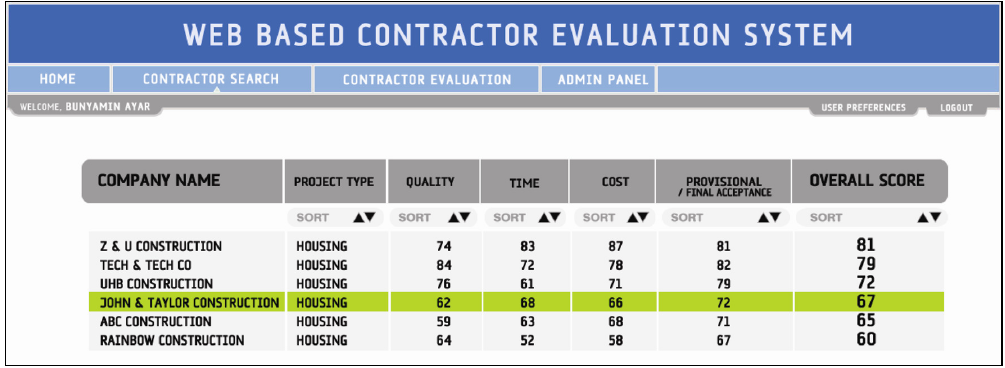
Fig. 4. An example of a GC search result